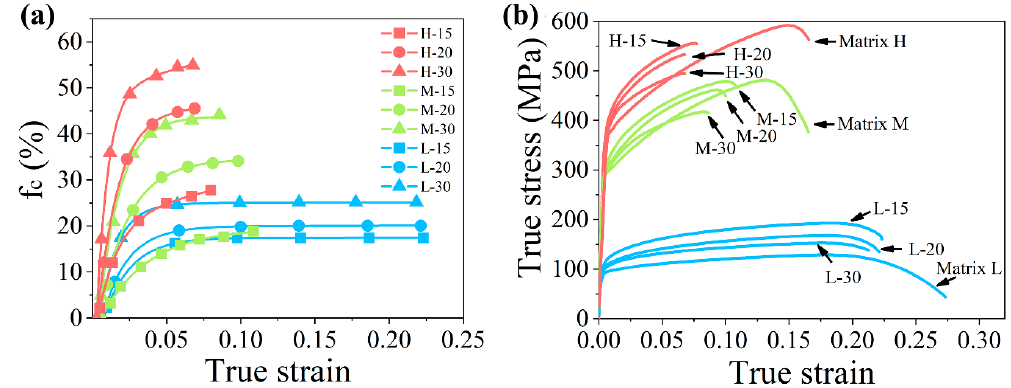
Figure 4. ( a ) The fraction of the cracked particle (fc) as a function of the true strain and ( b ) true stress–true strain curve of all composites and their matrices.